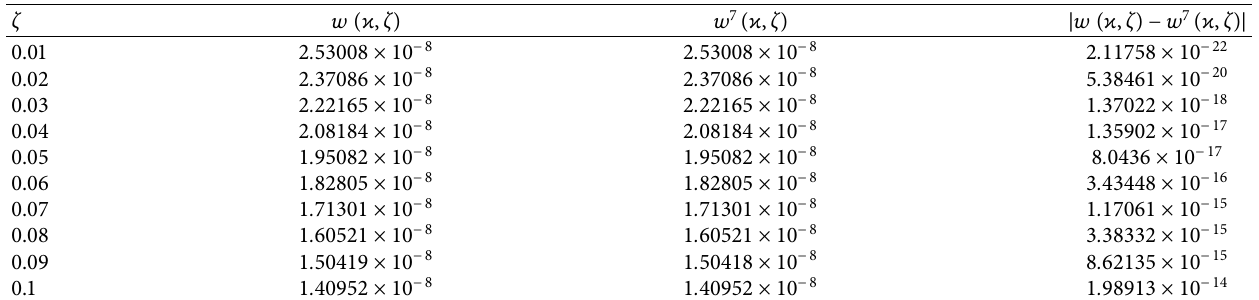
Table 8: | w ( ϰ , ζ ) − w 7 ( ϰ , ζ )| of Problem 1 at ϰ � 0 . 003 when ϖ � 1 . 0 determined by LRPSM at plausible locations in the range ζ ∈ [ 0 , 0 . 1 ] .